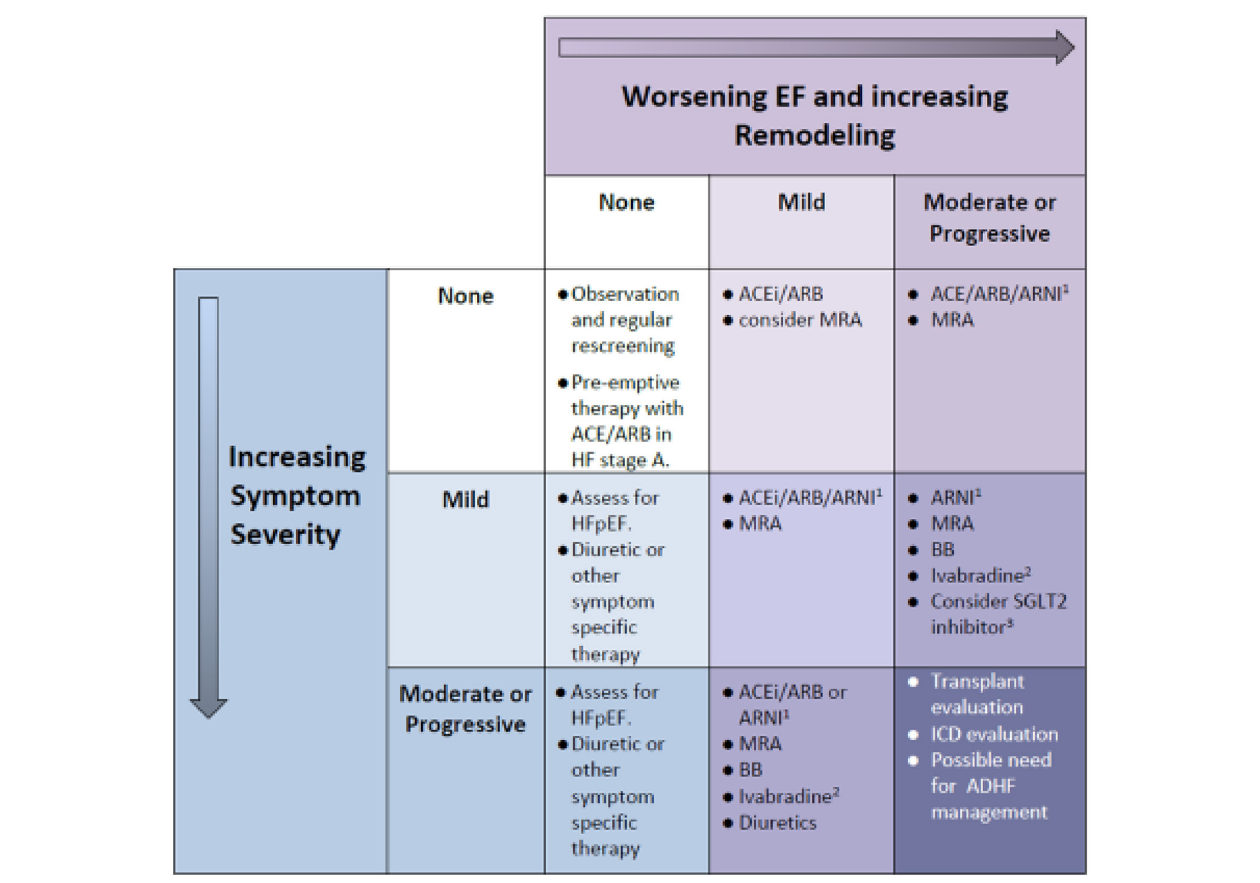
FIGURE 3 | Which Drug for Which Patient: a simplified intuitive guide to the assignment of medical treatment in chronic HF. Remodeling severity is portrayed on the horizontal axis, with increasingly severe symptoms on the vertical axis. Note that progressive symptoms in the absence of LV dilation implies restrictive diastolic function (a form of HFpEF), which may be refractory to management and also require assessment for cardiac transplant and/or ICD. When symptoms are severe and remodeling is advanced (lower right cell) we revert to acute decompensated heart failure management. All patients require an expert assessment and a tailored approach to management depending on the etiology of HF, the severity of decline in EF and degree of LV remodeling (LV dilation). 1 Indications exist in adults, and use in children is FDA approved, although the outcome of a clinical trial in children is still awaited. 2 Indication is based on a phase II clinical trial in children, with FDA approval given for children over 6m age. 3 Class IIa indication in adults with HFrEF. ACE, angiotensin-converting enzyme inhibitor; ARNI, angiotensin receptor blocker/neprilysin inhibitor; BB, beta blocker; HFpEF, heart failure with preserved EF; MRA, mineralocorticoid receptor antagonist; SGLT-2, sodium glucose co-transporter protein